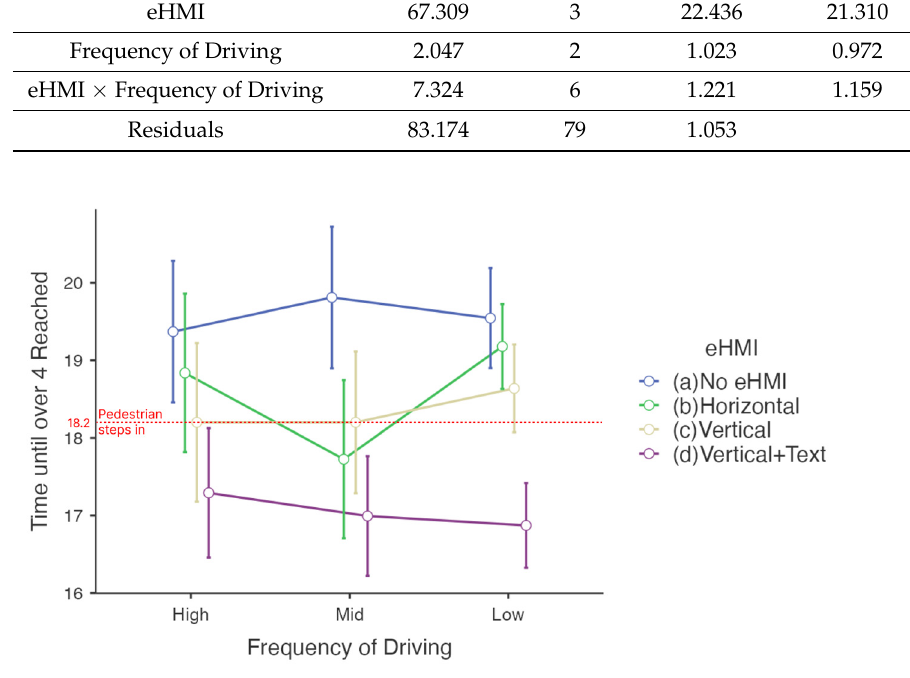
Figure 8. Time until level 4 of the willingness to stop scale was reached by frequency of driving (s).